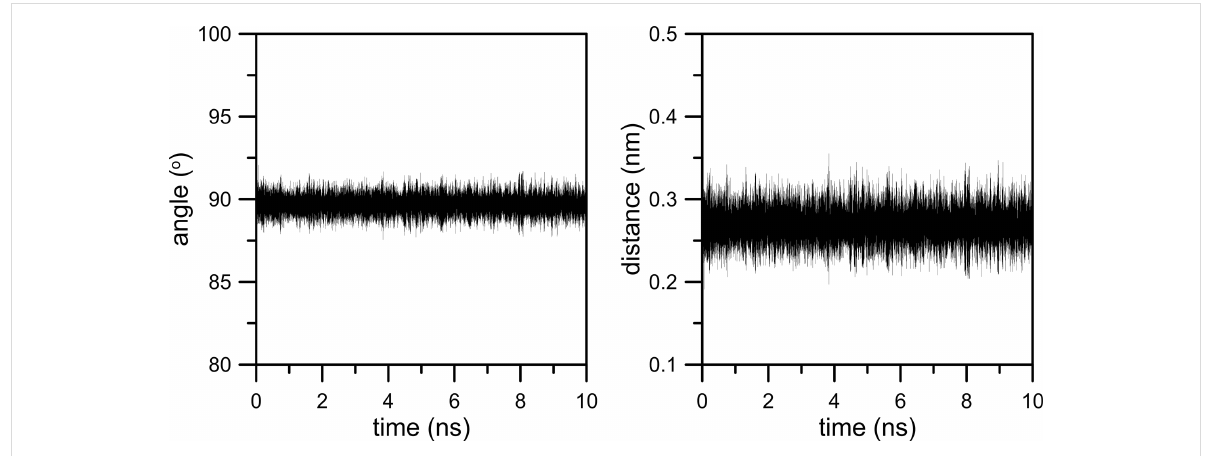
Figure 17: Evolution in time of the average angle between four vectors designated by four carbon atoms in every graphene corner and the nearest nitrogen atoms in the nanopore rim and the normal to the plane that includes four fixed carbon atoms in every graphene corner (first kind of deviation, left plot). The right plot presents the time dependence of the distance between the center of nanopore and that plane. Data were determined from the simulation trajectory of CH 4 + N 2 + 200 H 2 O at 300 K.